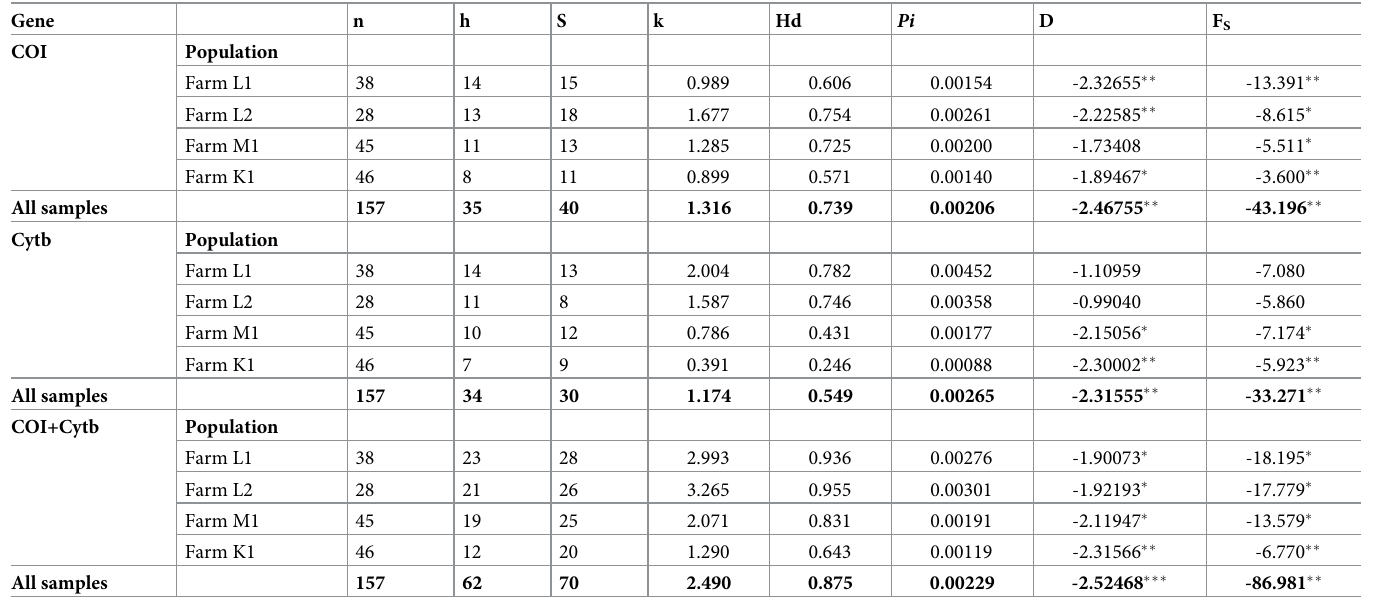
For each population and gene marker, the number of specimens (n), number of haplotype (h), number of polymorphic (segregation) sites (S), average number of nucleotide differences (k), haplotype diversity (Hd), nucleotide diversity (pi) and Tajima’s D (D) and Fu’s Fs (F S ) tests statistics are given. Values are significant at � P � 0.05; �� P �